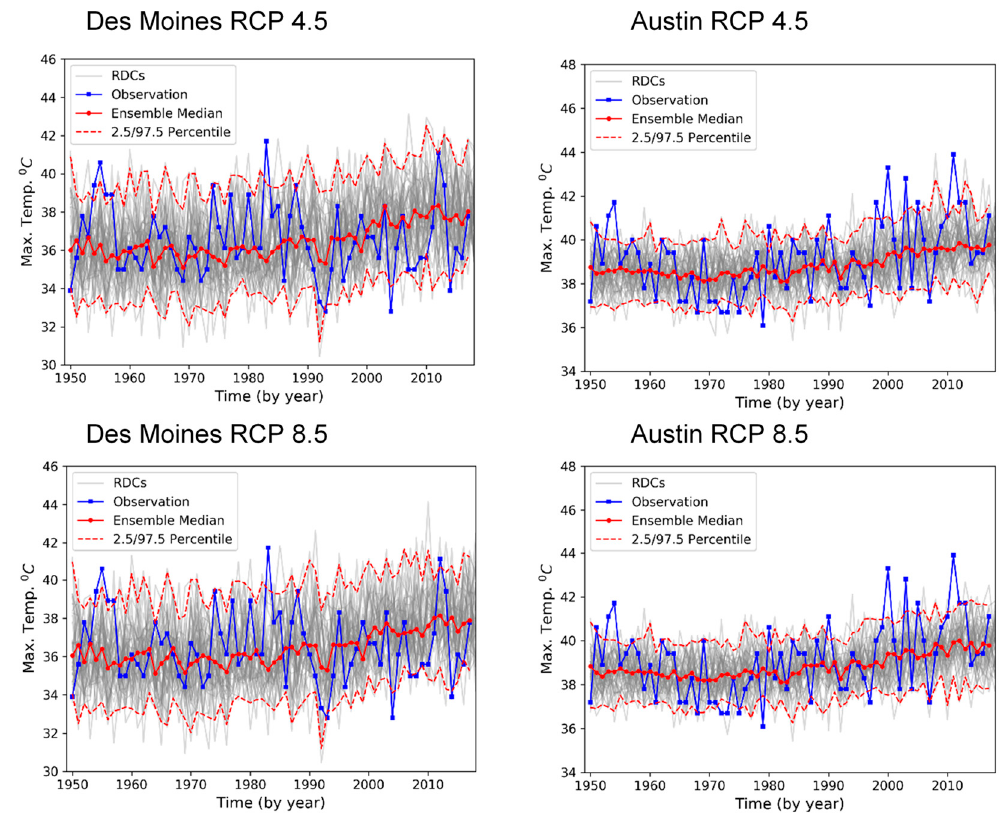
Figure 1. Annual peak temperatures from RDC ensemble data (light gray) and ASOS observations (dark blue) for Des Moines ( left ) and Austin ( right ) and by climate scenarios of RCP 4.5 ( top row ) and RCP 8.5 ( bottom row ) showing also RDC ensemble median (red line) with ensemble 2.5 and 97.5 percentile values (pink dashed lines).